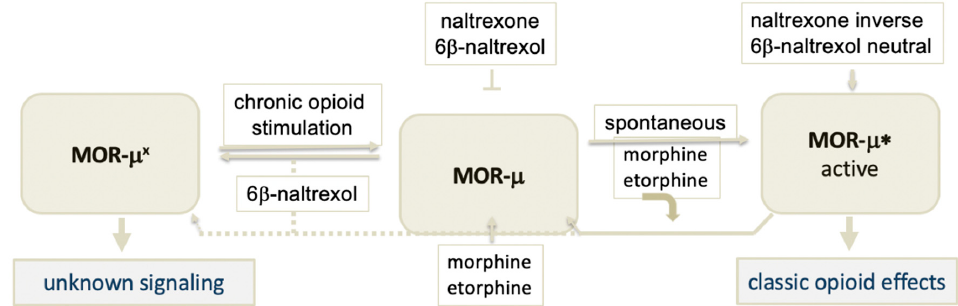
Figure 5. Extended model of the μ opioid receptor (MOR). Starting with the model shown in